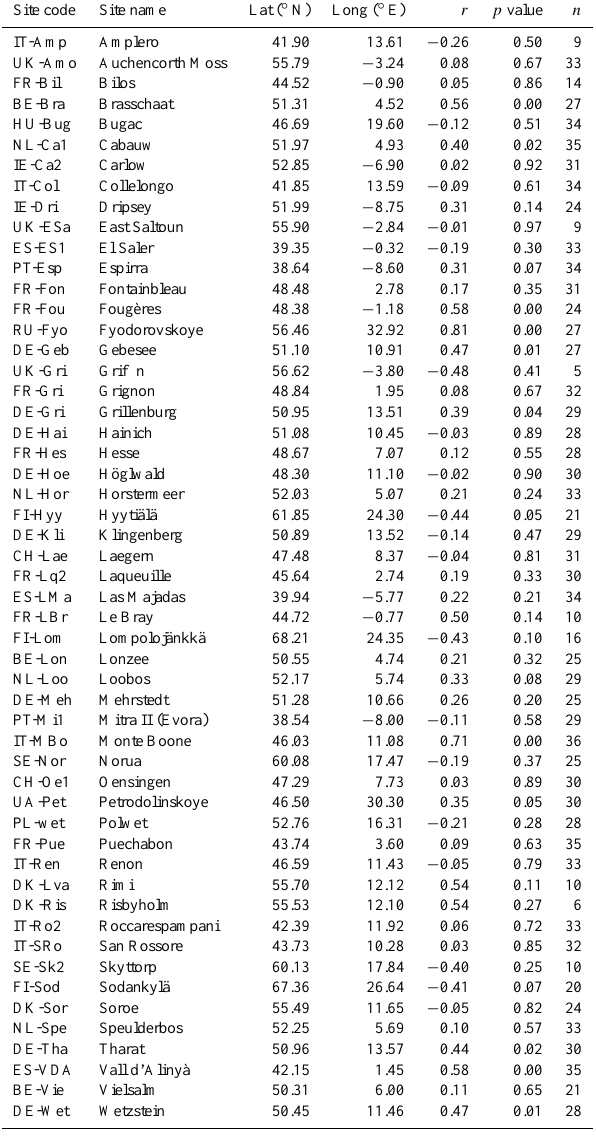
Table A1. Statistical analysis of the NEU data set and monthly IASI satellite surface concentrations comparison for each stations during 2008, 2009 and 2010. Each site is characterized by its site code and name, coordinates, its Pearson’s correlation coefficient ( r ) and the associated p value as well as its number of points ( n ). Only monthly values with a relative IASI retrieval errors below 100% have been taken into account.